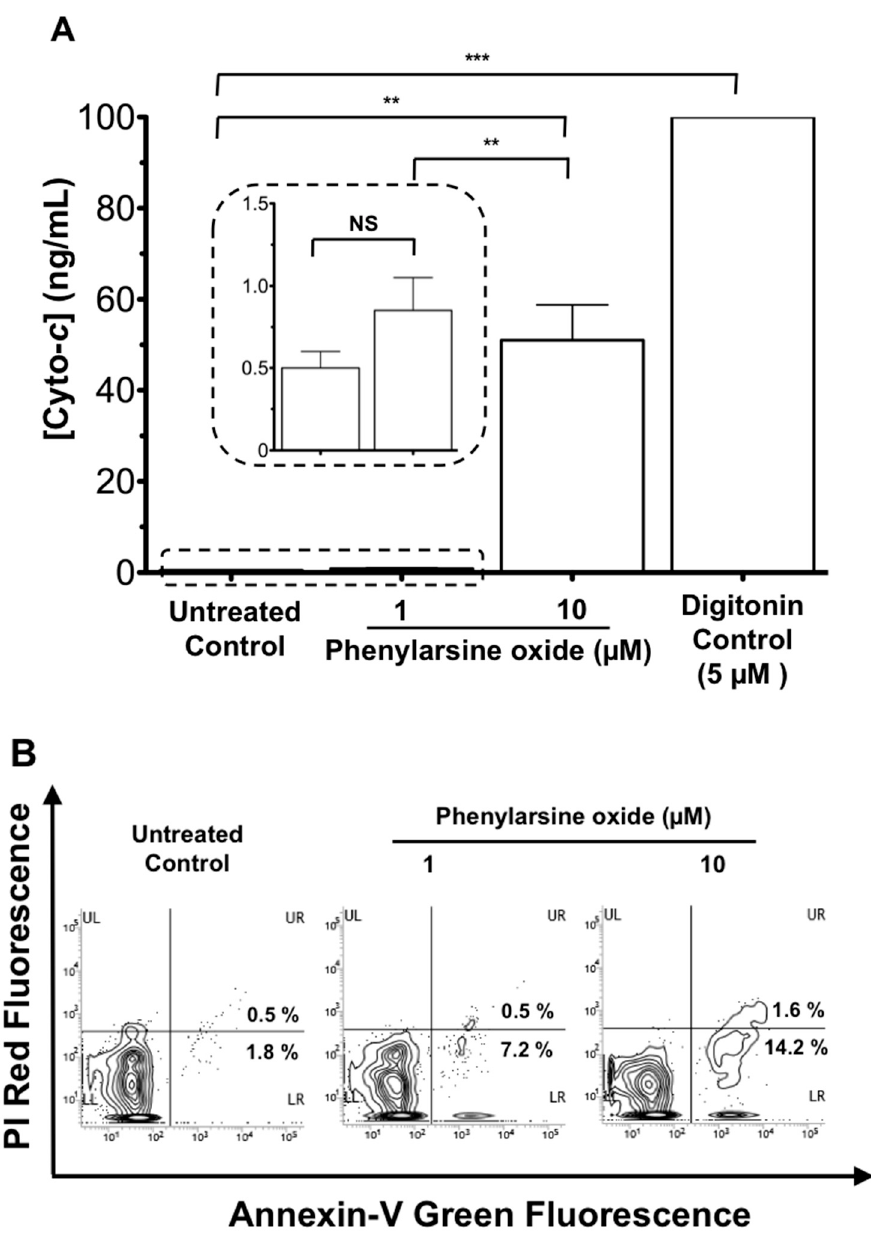
Figure 6. Cyto- c release during anti-cancer drug treatment using leukemia-sparked samples. HL-60 cells (1 × 10 5 /mL) in serum were cultured with the anti-cancer drug phenylarsine oxide at a concentration as indicated (1, 10 μ M) or digitonin (5 μ M) as a positive control at 37 °C, 5% CO 2 for 1 h. ( A ) Cell-free sera were then collected by filtering with a 0.2 μ m filter unit and subjected to the AuNR-LSPR assay for determining the release of cyto- c . Results are mean ± SEM ( n = 3), NS p > 0.05, * p < 0.05, ** p < 0.01, *** p < 0.001. ( B ) Cells after treatment were labeled with Annexin-V-GFP and PI. After washing, cells were subjected to flow cytometric analysis for green and red fluorescence. The fluorescence properties of 1000 cells were collected for analysis.